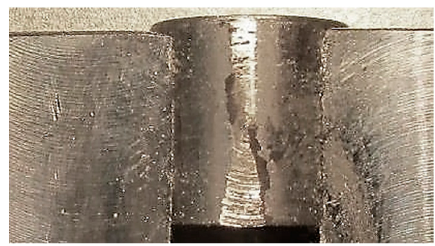
Figure 14. The example of a wear.